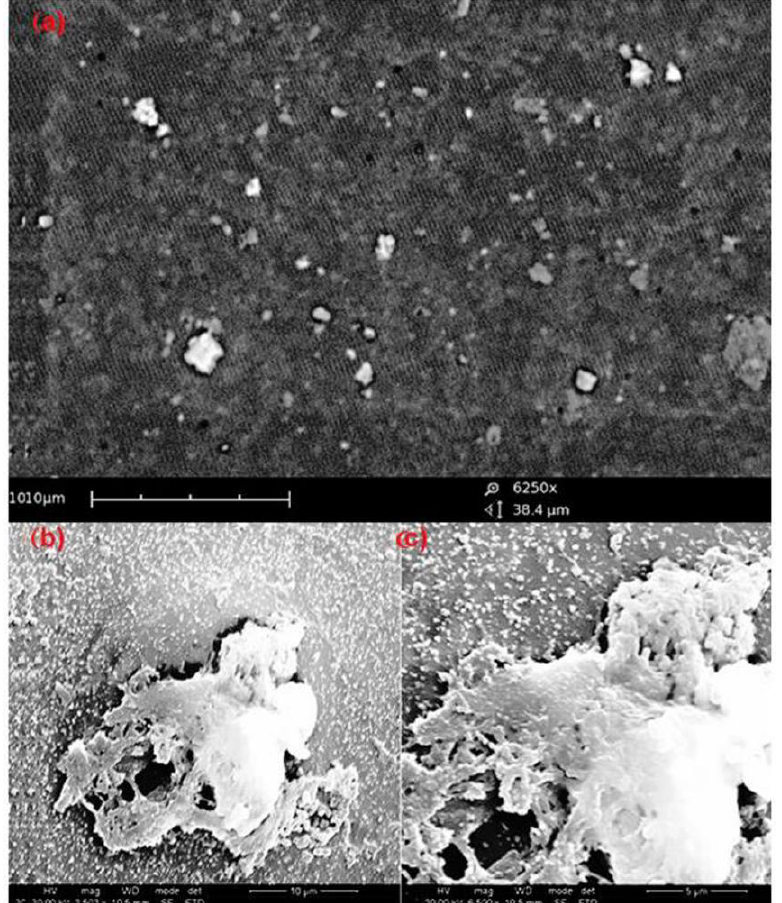
Figure 4. The SEM pictures of osteoblast-like MG63 cells adhered to the 3D-printed biomaterial scaffold on day seven, whereby ( a ) depicts reference scaffold (scaffold without cells), ( b ) depicts day 7 cell adhered on the surface of the printed scaffold, ( c ) depicts magnified day 7 of cell adhered to the surface of the printed scaffold.